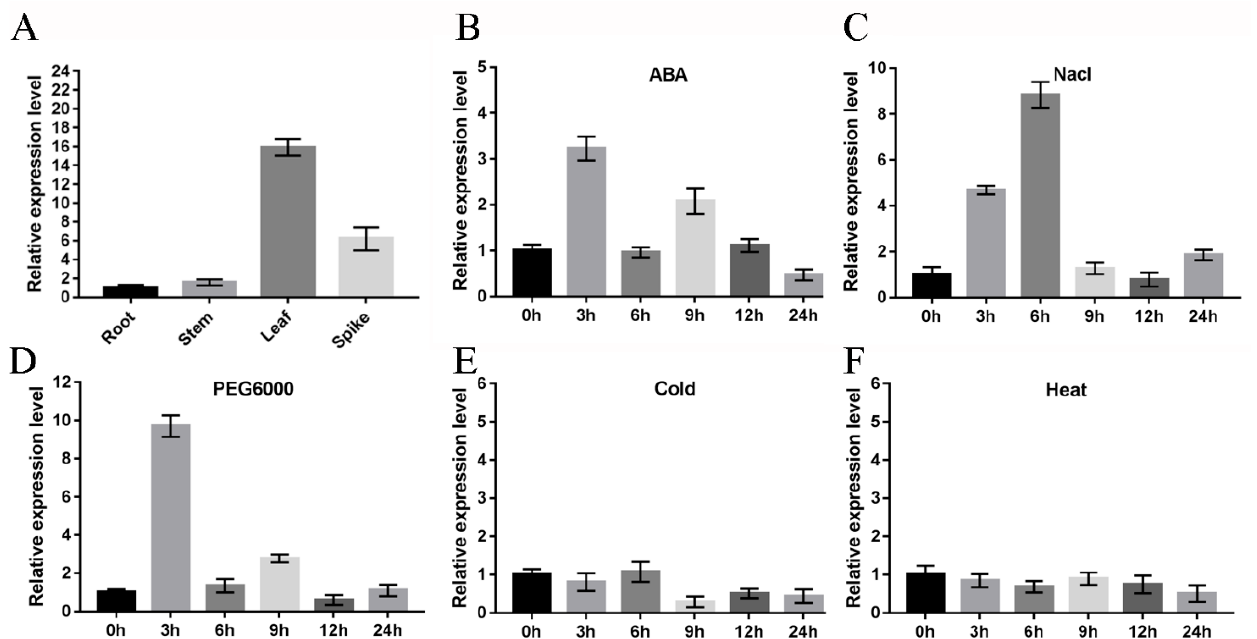
Figure 2. Expression analysis of TaNBR1 in wheat. ( A ) Expression patterns of TaNBR1 in different wheat tissues. ( B – F ) Expression patterns of TaNBR1 under different stress treatments. Wheat seedlings were subjected to treatment with 0.2 mM abscisic acid (ABA), NaCl (200 mM), 15% PEG6000, cold (4 ° C), and heat (42 ° C), and the leaves were then collected at different time points, as indicated. TaActin was used as the internal control.